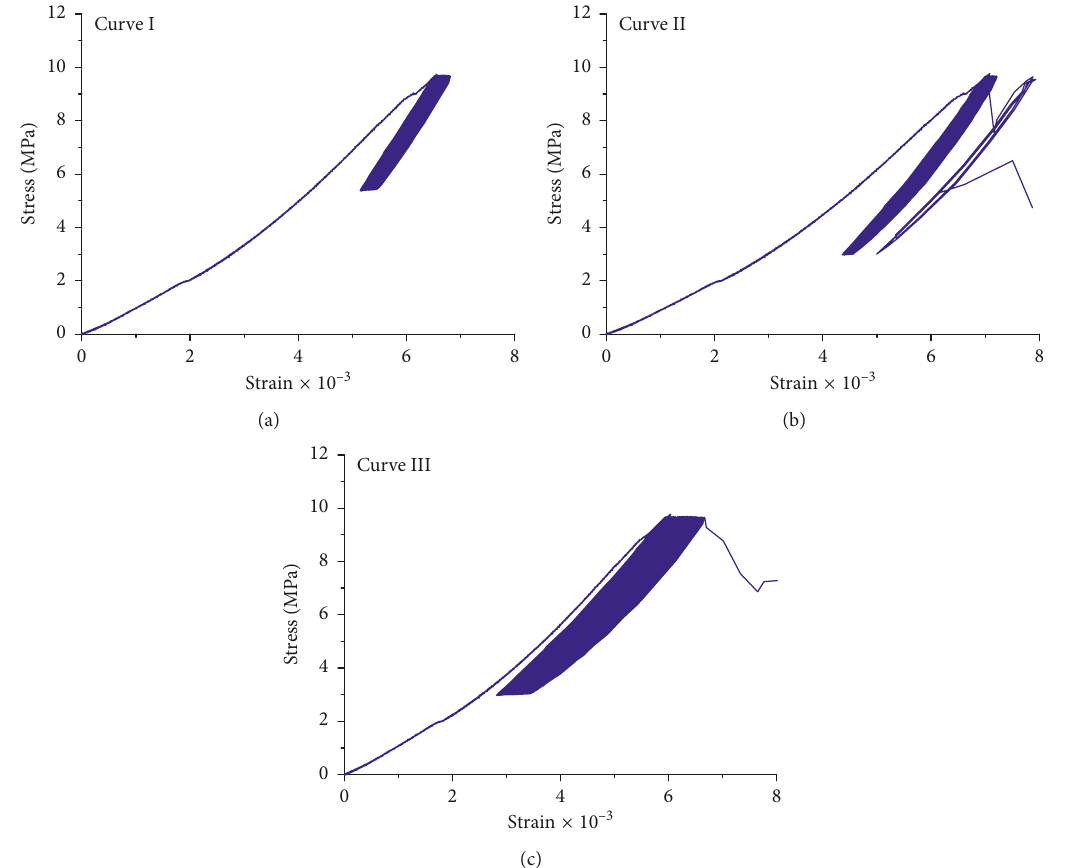
Figure 4: Cyclic loading stress-strain curve of the cylinder